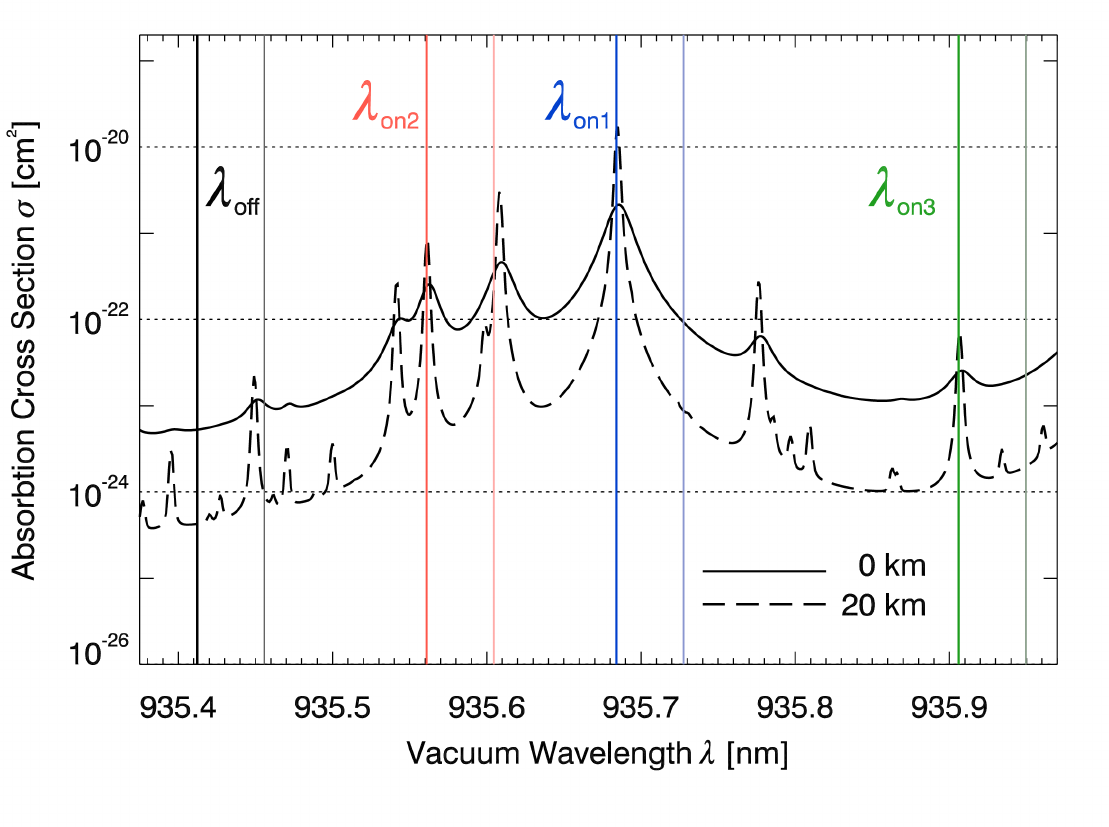
Figure 5. Water vapour molecular absorption cross sections σ as a function of vacuum wavelength λ using the HITRAN 2008 database [53] for sea level (solid line) and an altitude of 20 km (dashed line) according to US Standard Atmosphere conditions. Wavelengths used in this study are indicated by vertical thick lines; the additional thin lines represent the Doppler shifted wavelengths on the backward path. Water vapour absorption of the first and second harmonics generated by the transmitter is